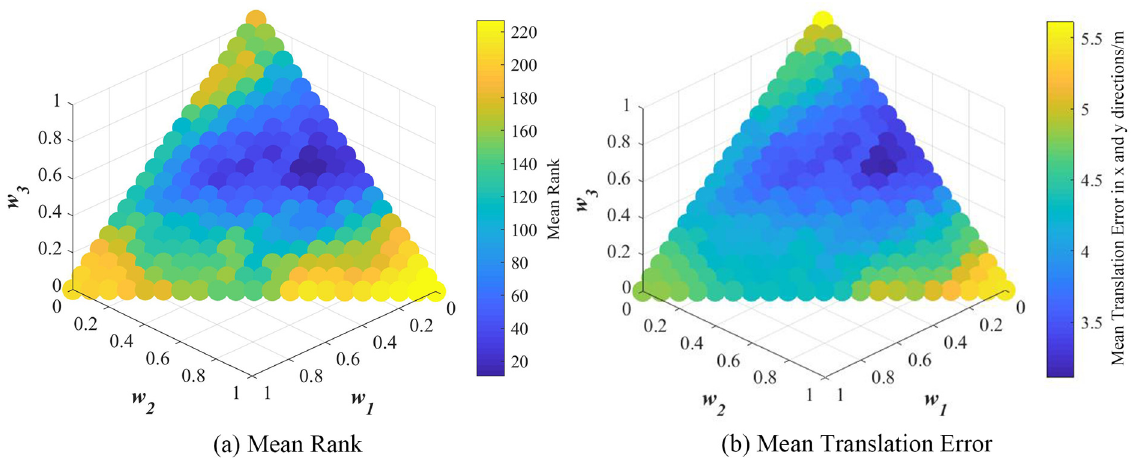
Figure 10. The registration result of all groups of weights in the coarse registration.